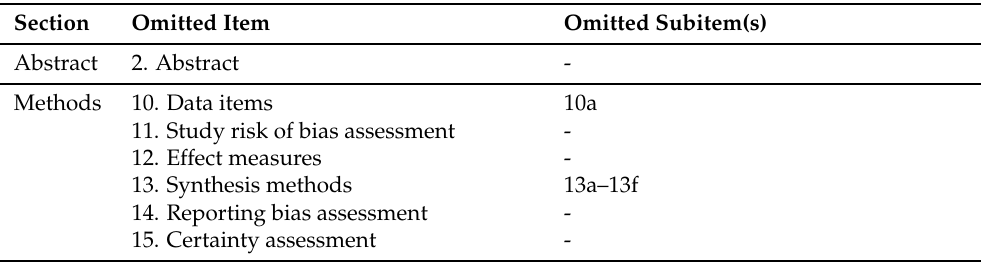
Table 1. PRISMA checklist elements omitted from our review due to not being applicable. Items without explicitly mentioned subitems were omitted